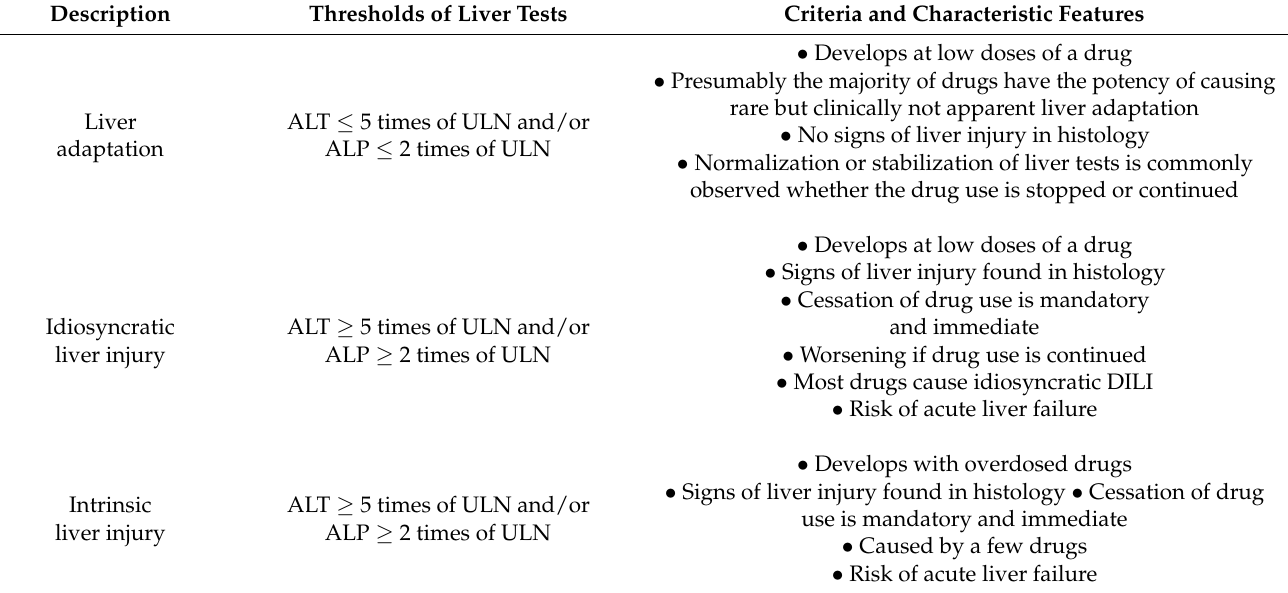
Table 1. Thresholds of ALT and ALP and typical features in patients with liver adaptation and liver